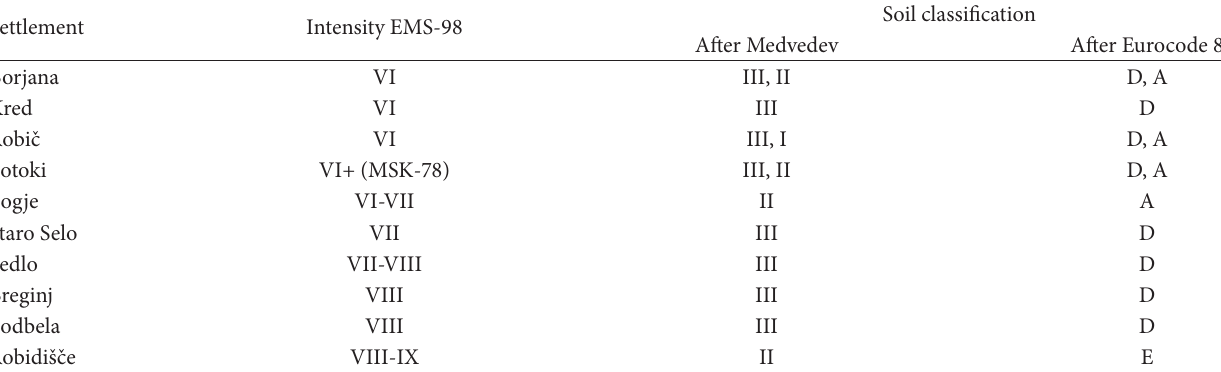
Table 6: Intensities of 1976 earthquake in different settlements of Breginjski kot and soil classification after Medvedev and Eurocode 8 from both seismic microzonation